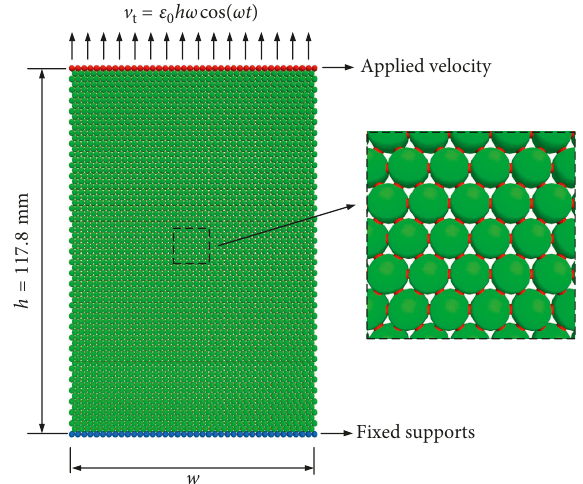
Figure 6: The discrete element model of an uncracked plate subjected to imposed sinusoidal strain.